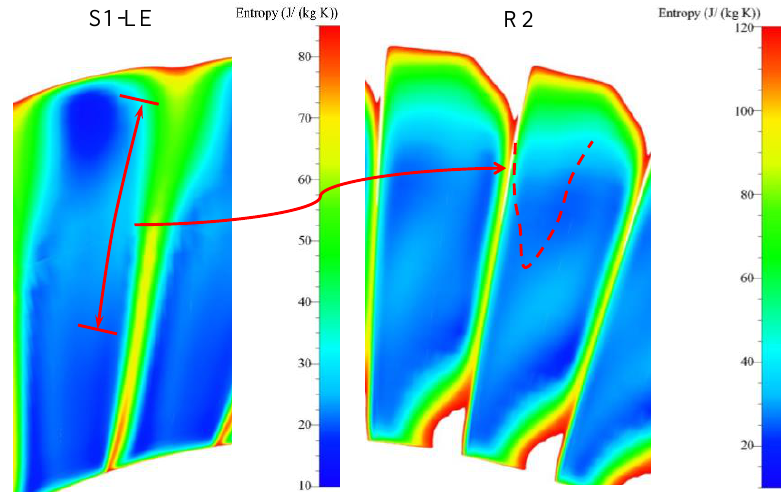
Figure 14. The propagation of the R1 shock wave influence. Figure 14 . The propagation of the R1 shock wave influence .